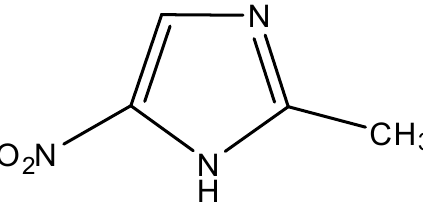
Figure 5. Structural formula of 2-methyl-5-nitroimidazole.